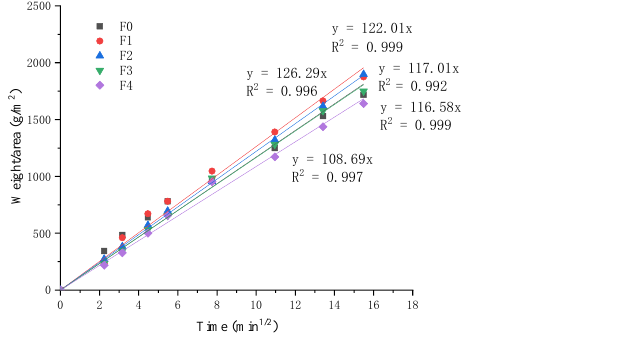
Figure 7. Water absorption of NS-modified mortar.